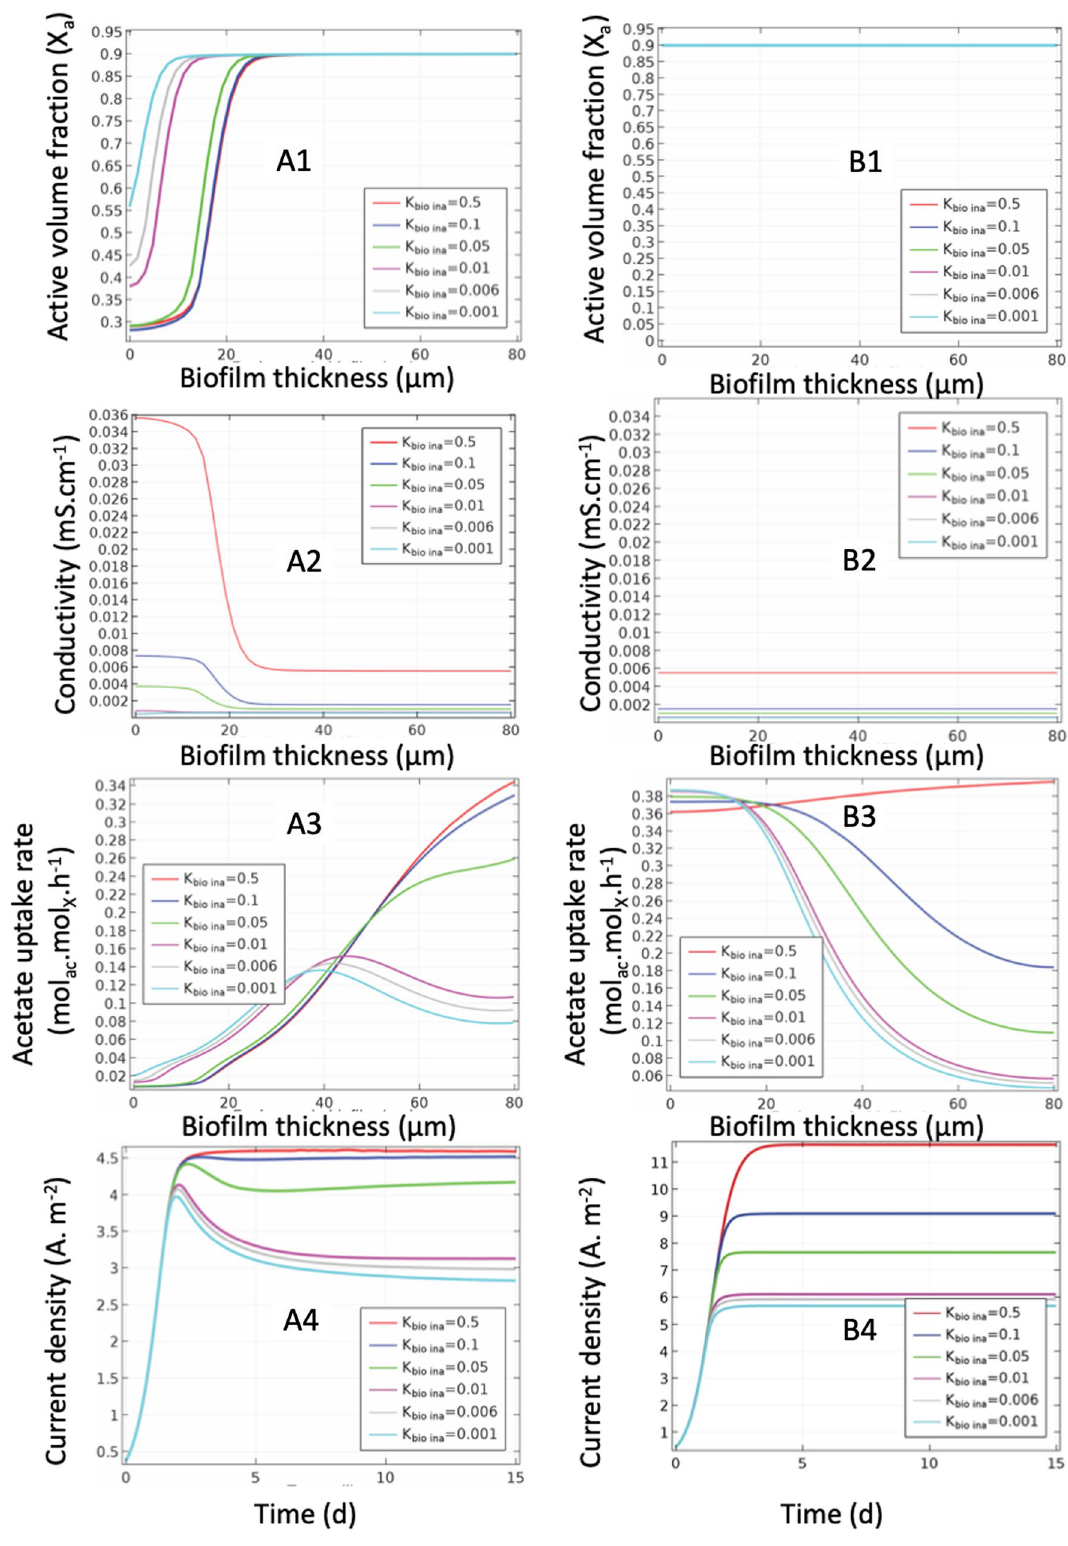
Figure 6. Influence inactive fraction conductivity on biofilm performance. A1 to A4: results for C bac = 0.5 mM; B1 to B4: results for and C bac = 3 mM with 1: active volume fraction; 2: conductivity; 3: Acetate uptake rate, all vs biofilm thickness; 4: current density vs